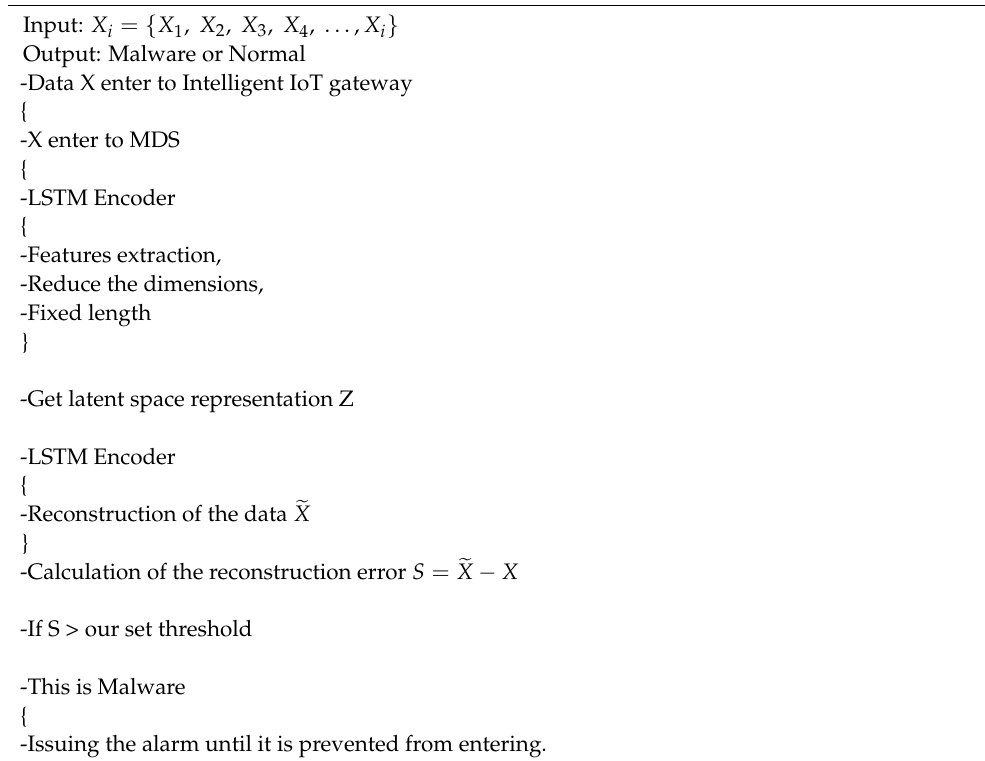
Algorithm 1: Data come from external networks to IoT